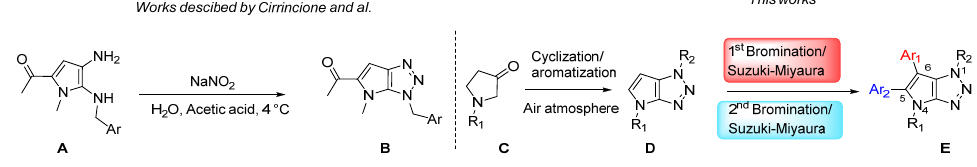
Figure 1. Access to pyrrolo[2,3- d ][1,2,3]triazoles .